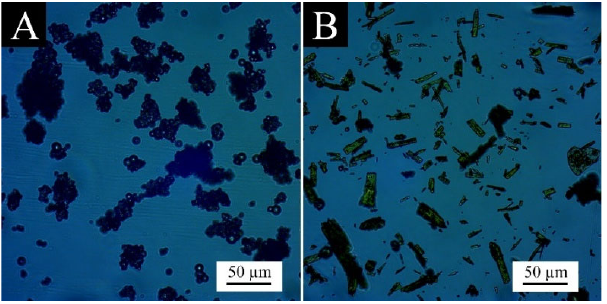
Figure 3. OM images of wall and core material: ( A ) wall material and ( B ) core material.